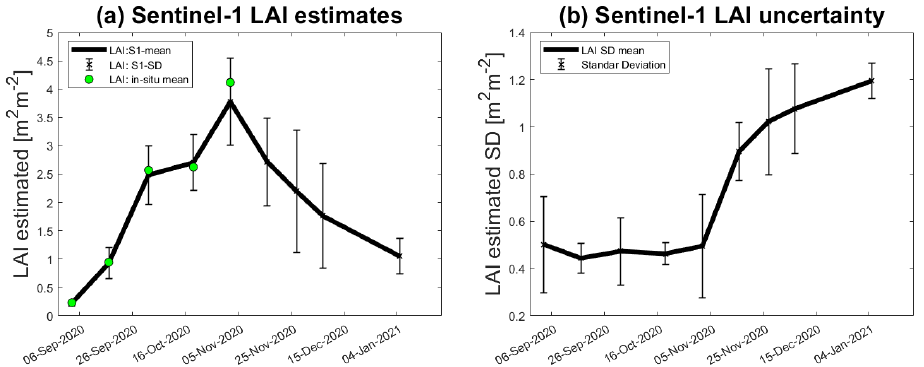
Figure 10. Seasonal evolution of wheat cropland over the three paddocks at the BVCR study sites described by LAI, mean values of nine ESUs within the cropland limits, and the associated uncertainty, plotted as vertical bars. ( a ) LAI estimates; ( b ) LAI uncertainty (SD).